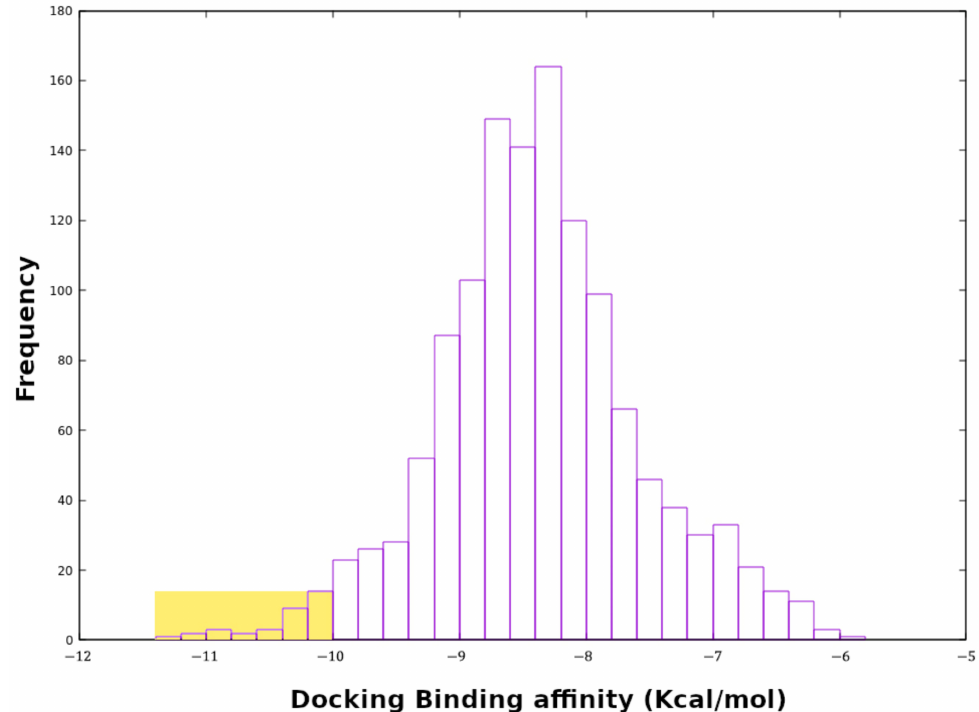
Figure 1. Histogram plot of dock-binding affinity of all flavonoids. The docking scores of the selected flavonoids in the left part are highlighted in